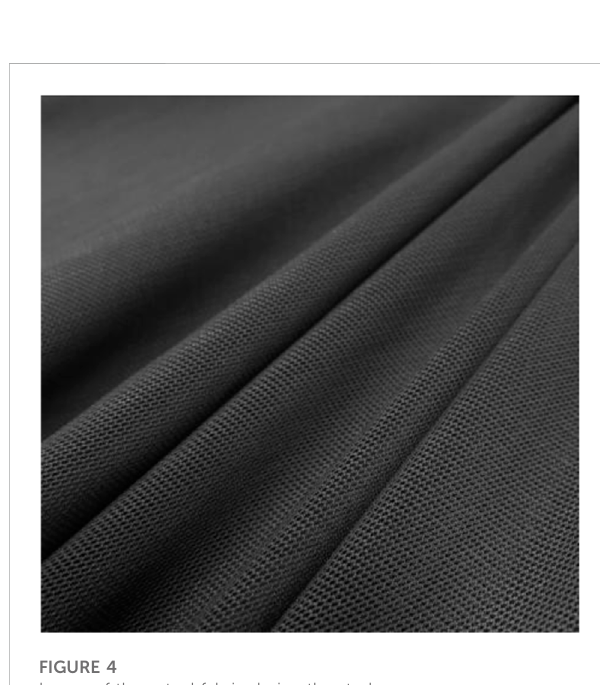
FIGURE 4 Image of the actual fabric during the study.